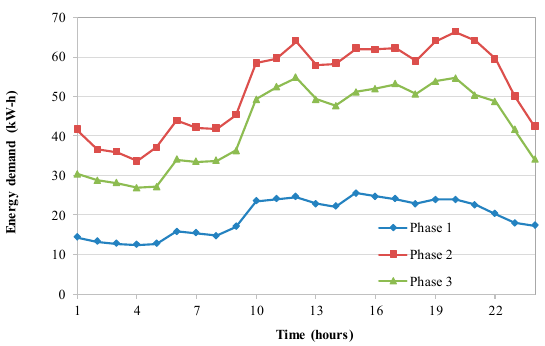
Figure 8. Initial demand curves for Bariloche, Argentina.